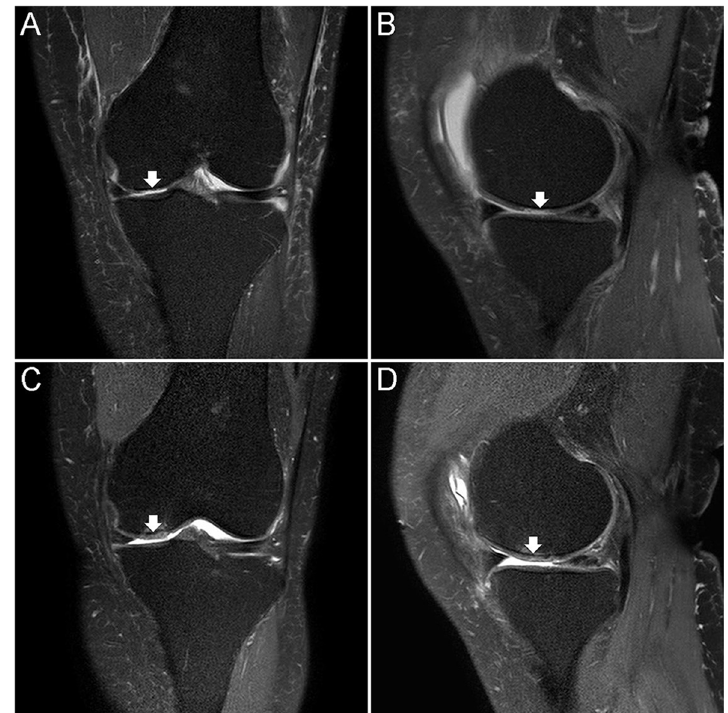
Fig. 1 Preoperative ( A and B ) and follow-up ( C and D ) coronal and sagittal proton density fat-saturated images of the right knee of a 64-year-old female patient. A and B Cartilage loss is visible in the medial femoral condyle (arrows). C and D Complete filling of the defect along with complete integration with the adjacent native cartilage (arrows; MOCART score, 75 points)